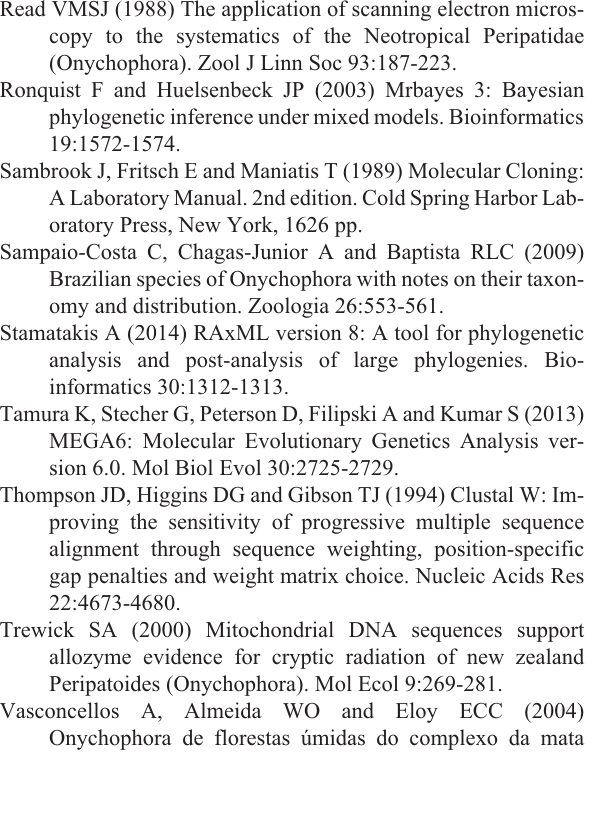
Figure S1- Maximum-likelihood tree for three genes (COI, 16S,